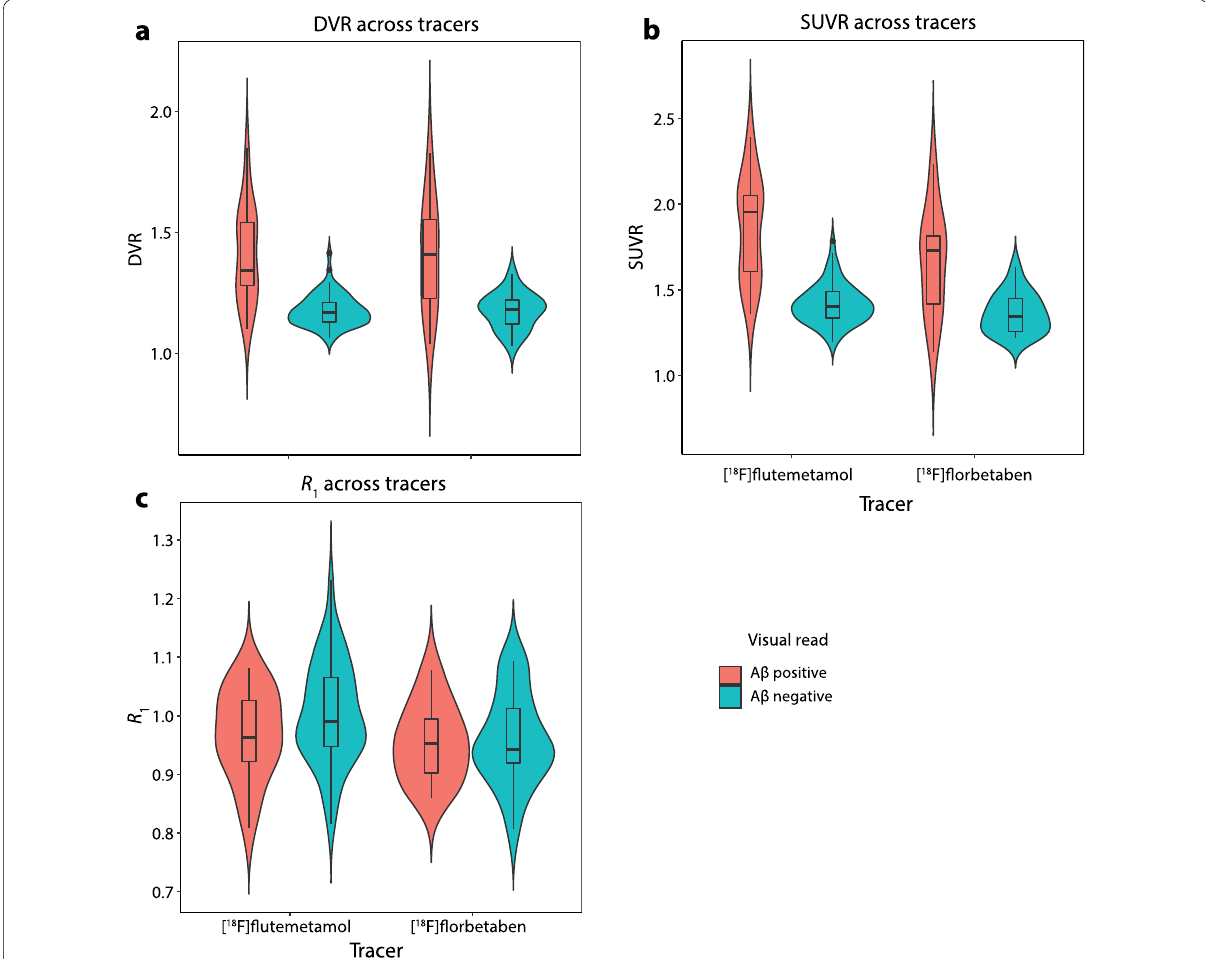
Fig. 1 Parameter distribution across tracers . Violin plots showing the distribution of a DVR, b SUVR and c R 1 for Aβ positive and negative scans. Small boxplots inside the violin plots display median and quartile range of the